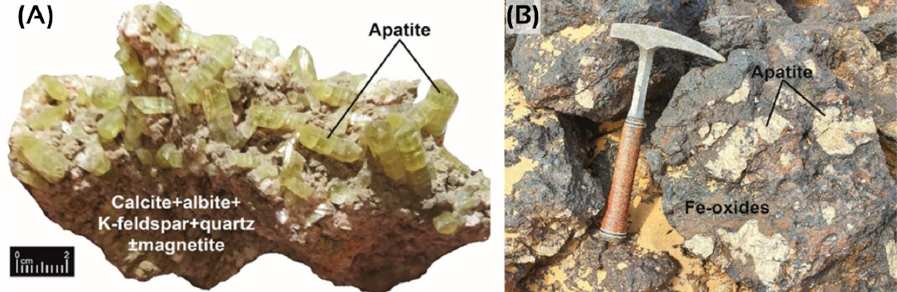
Figure 12. Photographs of the Moroccan apatite ores: ( A ) High Atlas Imilchil apatite gems [19]. ( B ) Dakhla Gleibat Lafhouda iron oxide–apatite ore associated with carbonatite complex